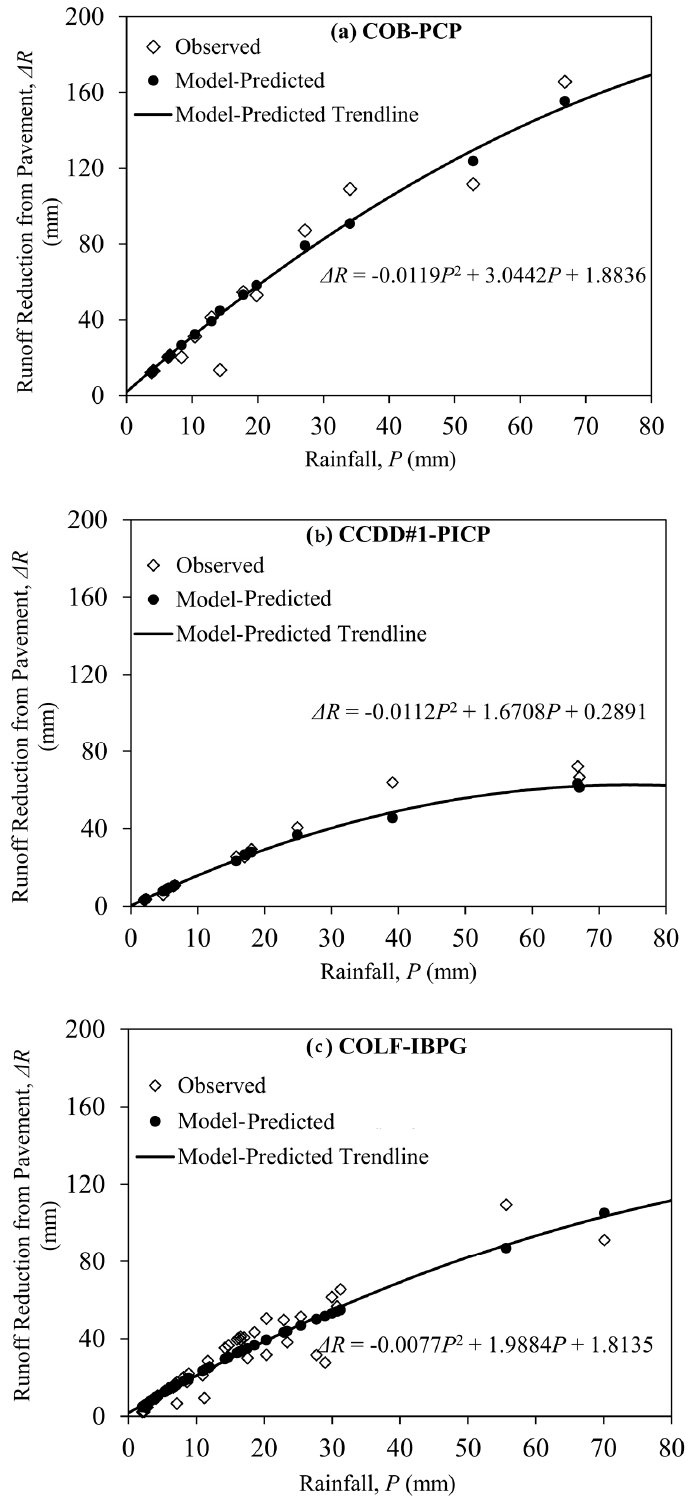
Figure 5. Plot demonstrating the runo ff reduction behavior of permeable pavements as a function of observed rainfall magnitudes within the monitoring timeframe. ( a ) City of Brownsville (COB)-Porous Concrete Pavement (PCP), ( b ) Cameron County Drainage District#1 (CCDD#1)-Permeable Interlocking Concrete Pavement (PICP), and ( c ) City of La Feria (COLF)-Interlocking Block Pavement with Gravel